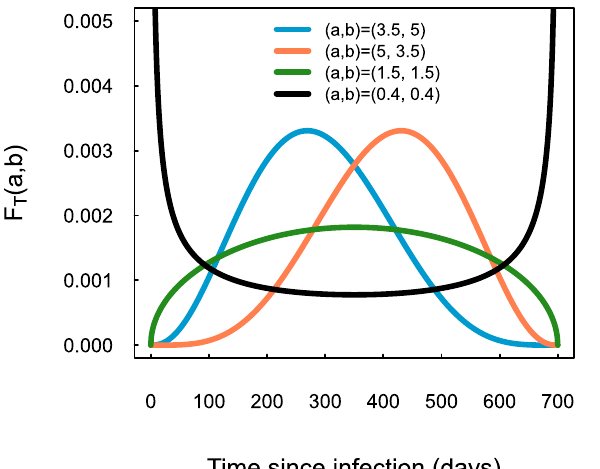
Fig 2. Hypothetical Time Since Infection distributions. These distributions have a Beta distribution kernel with parameters a and b . They are meant to represent different epidemic scenarios (akin to those in [18]). The blue line represents the case of an “ emerging ” epidemic; the orange line a “ waning ” epidemic; the green line a “ stable ” epidemic; and the black line an epidemic that has been partially controlled for a period of time,